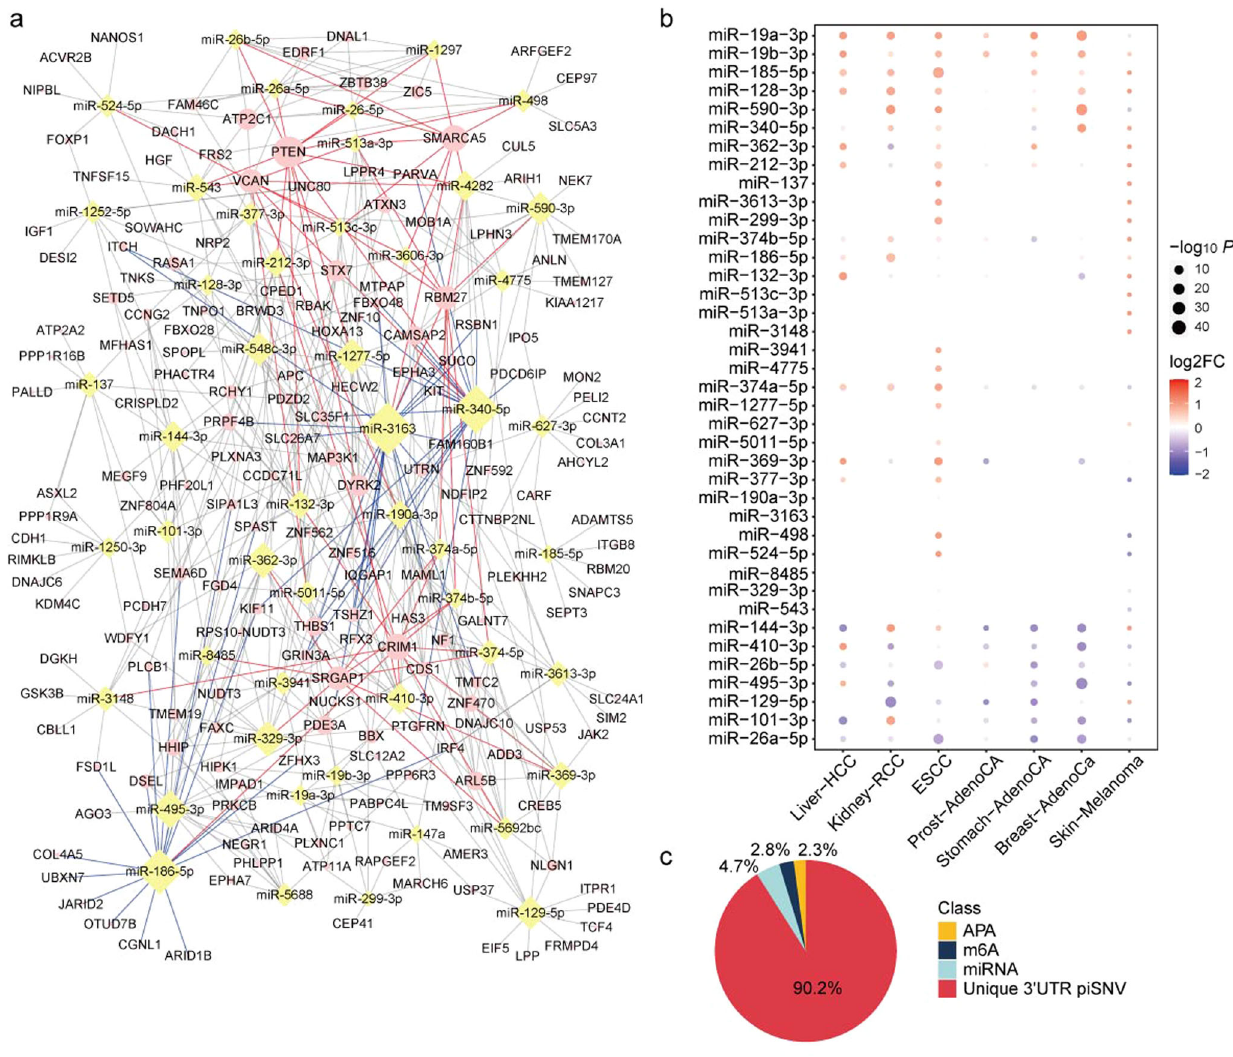
Fig. 4 The effect of post-transcriptional regulation on miRNA/m6A/APA. a Interaction network between top 50 recurrent binding miRNAs and 3 ’ -UTR piSNV genes, blue lines are the edges of top 3 recurrent binding miRNAs (miR-3163, miR-340-5p and miR-186-5p), and red lines are the edges of the major targeted 3 ′ -UTR piSNV genes ( PTEN , CRIM1 , SMARCA5 , VCAN , SRGAP1, and RBM27 ). b Expression of top 50 recurrent binding miRNAs in different cancer types. c The quantitatively distribution of 3 ′ -UTR piSNV in APA, m6A, and miRNA binding